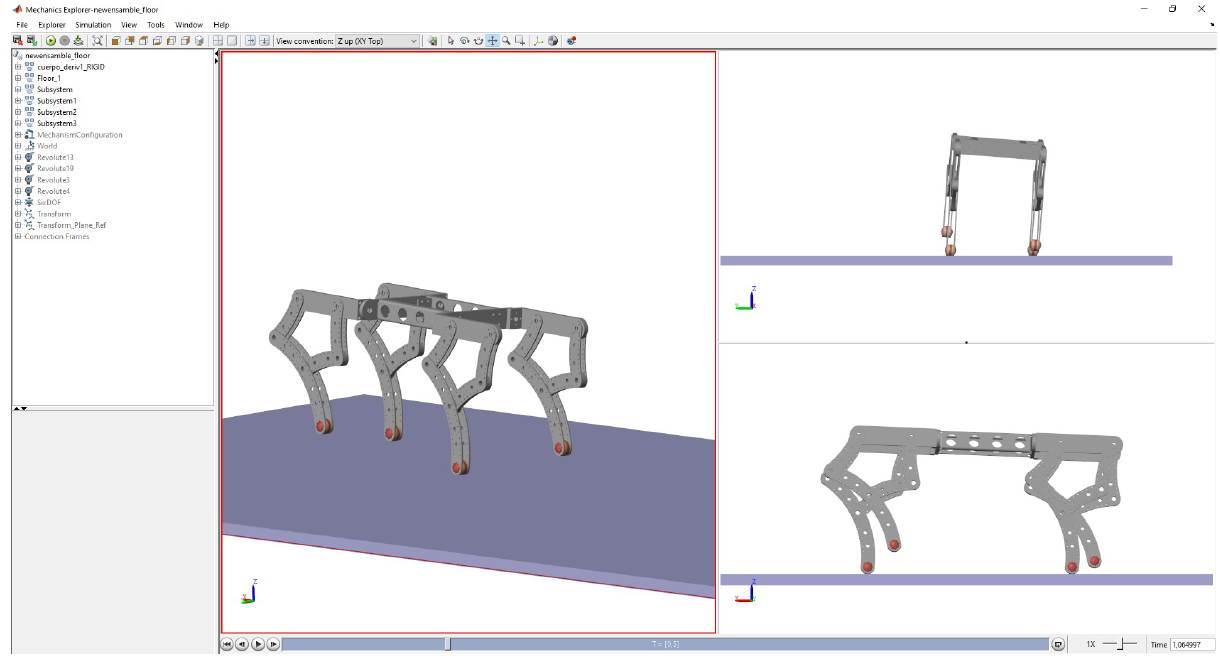
Figure 7. Quadrupedal gait 3D